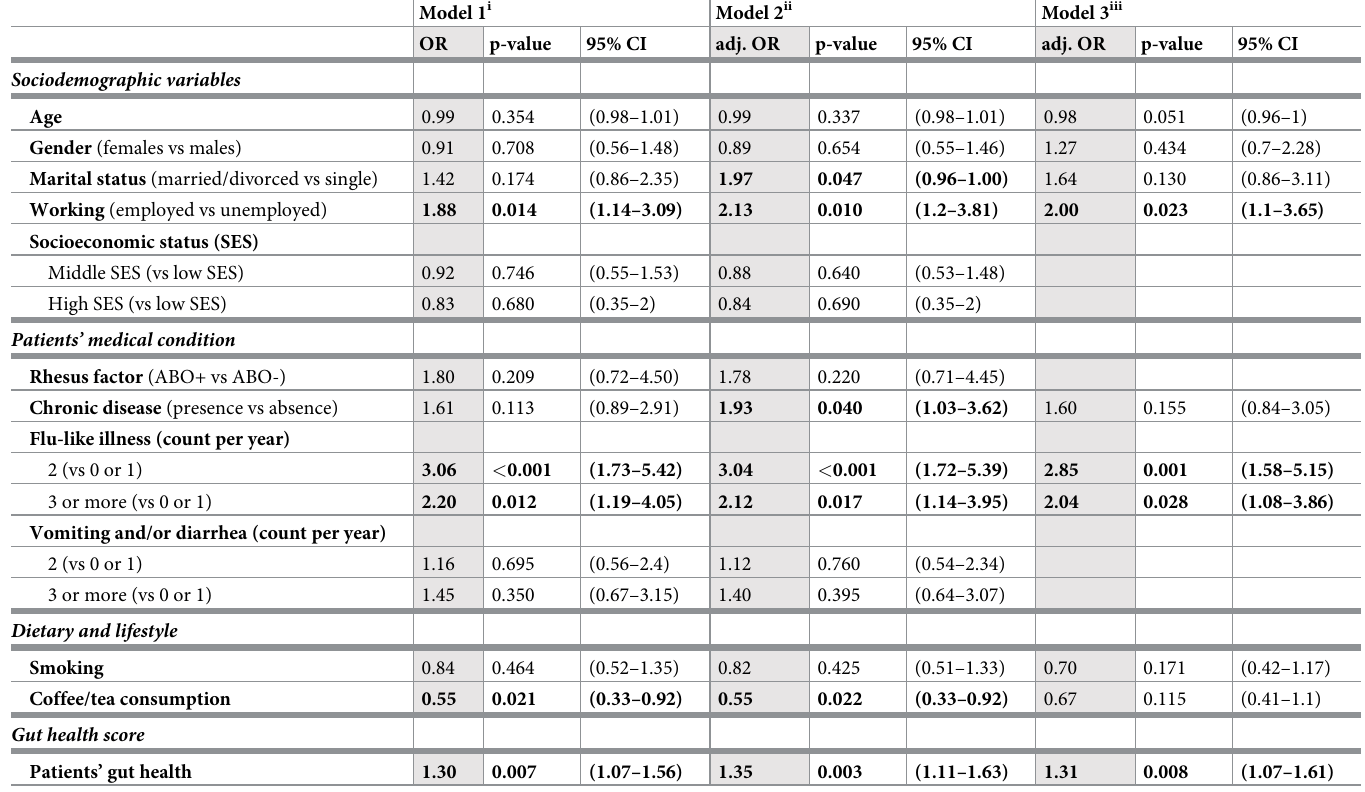
Table 5. Determinants of COVID-19 symptoms using simple and multiple ordinal logistic